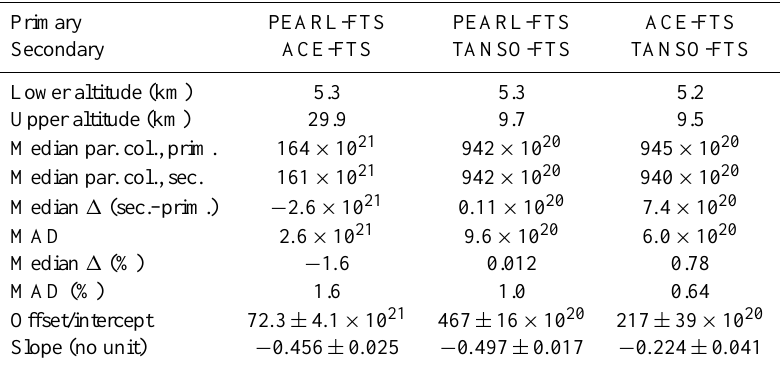
Table 2. Summary of partial column differences. The upper two rows show the range over which partial columns are calculated, based on an optimization of the information content as described in Sect. 3.2. The median (cid:49) shows the median of secondary–primary. MAD is median absolute deviation. Unless indicated otherwise, all units are in moleculescm − 2 .